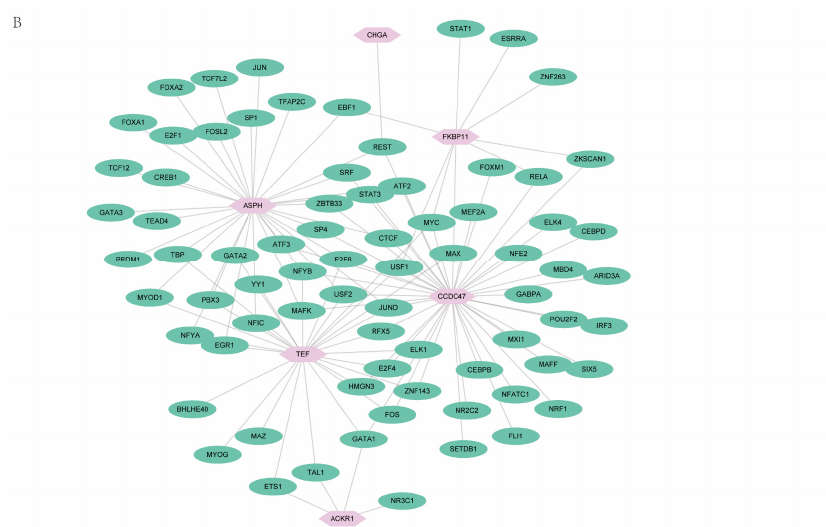
Figure 7. PPI analysis of target gene. ( A ). Target gene-miRNA network analysis. Purple represents the predicted miRNA and yellow represents the target gene. ( B ). Target gene-transcription factor; and pink represents the target gene analysis. Green represents the predicted gene-transcription factors.